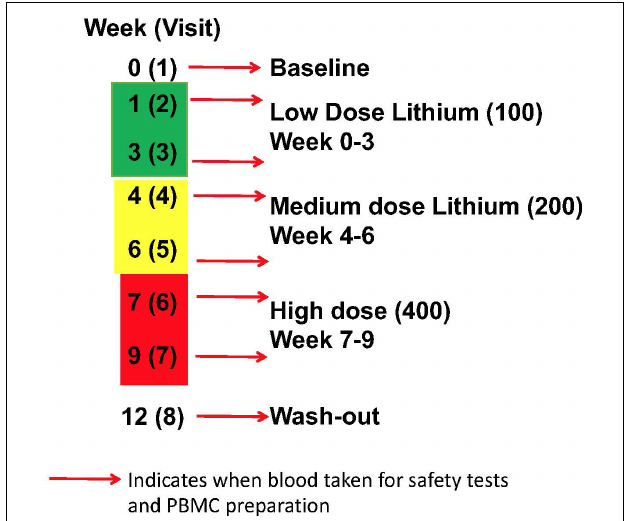
FIGURE 1 | Lithium intervention Study Design (Arm 2). Eleven volunteers were given low dose (100 mg daily) for 3 weeks, then medium dose (200 mg daily) for 3 weeks, high dose (400 mg daily) for 3 weeks, prior to a 3 week washout period. Blood samples were taken for safety measures, PBMC preparation and Lithium measure at baseline (visit 1), 1 and 3 weeks after starting each dose (visit 2–7), and after washout (visit